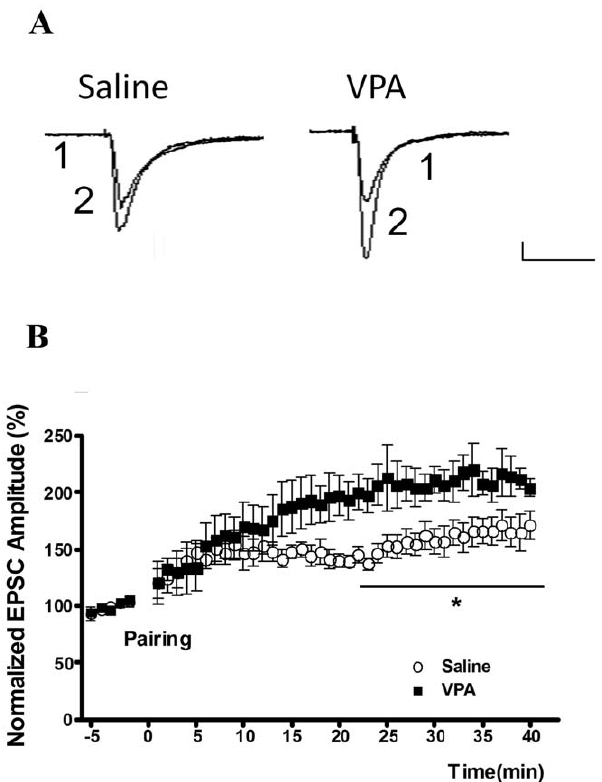
Figure 3. The LTP is enhanced in the VPA offspring at the thalamic–amygdala synapses. (A) Sample traces are the averaged EPSCs taken before (1) and 40 min after (2) LTP induction in the saline (n=6) and VPA (n=6) offspring. Scale; 50 ms, 40 pA. (B) LTP in the LA neurons was induced by pairing pre-synaptic stimulation (2 Hz, 200 pulses) with post-synaptic depolarization to 2 5 mV. The amplitude of individual EPSCs was normalized to the averaged amplitude of EPSCs during the 5-min baseline recordings just before LTP induction. *p , 0.05; scale 50 ms, 40 pA.